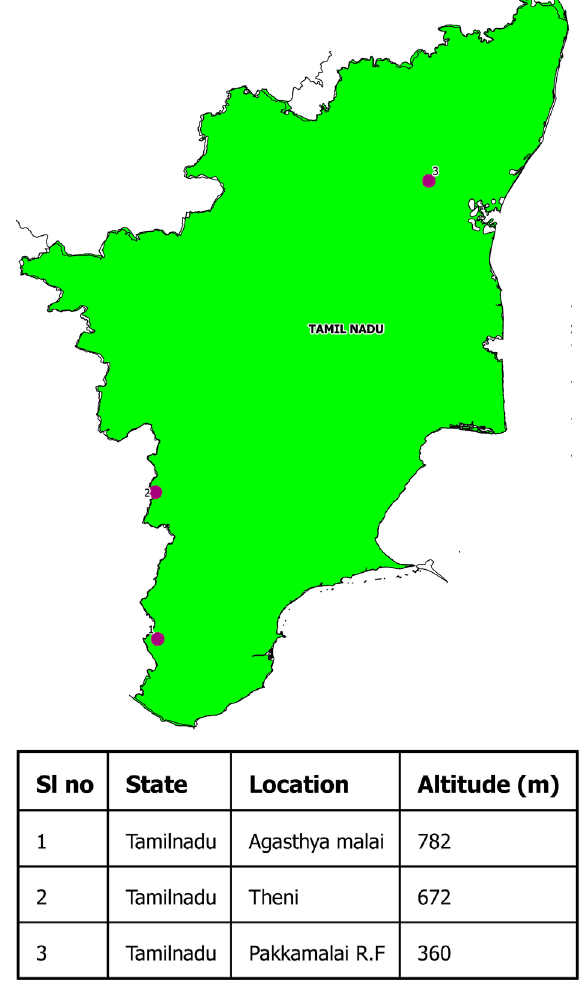
Figure 2. Distribution of Drypetes porteri